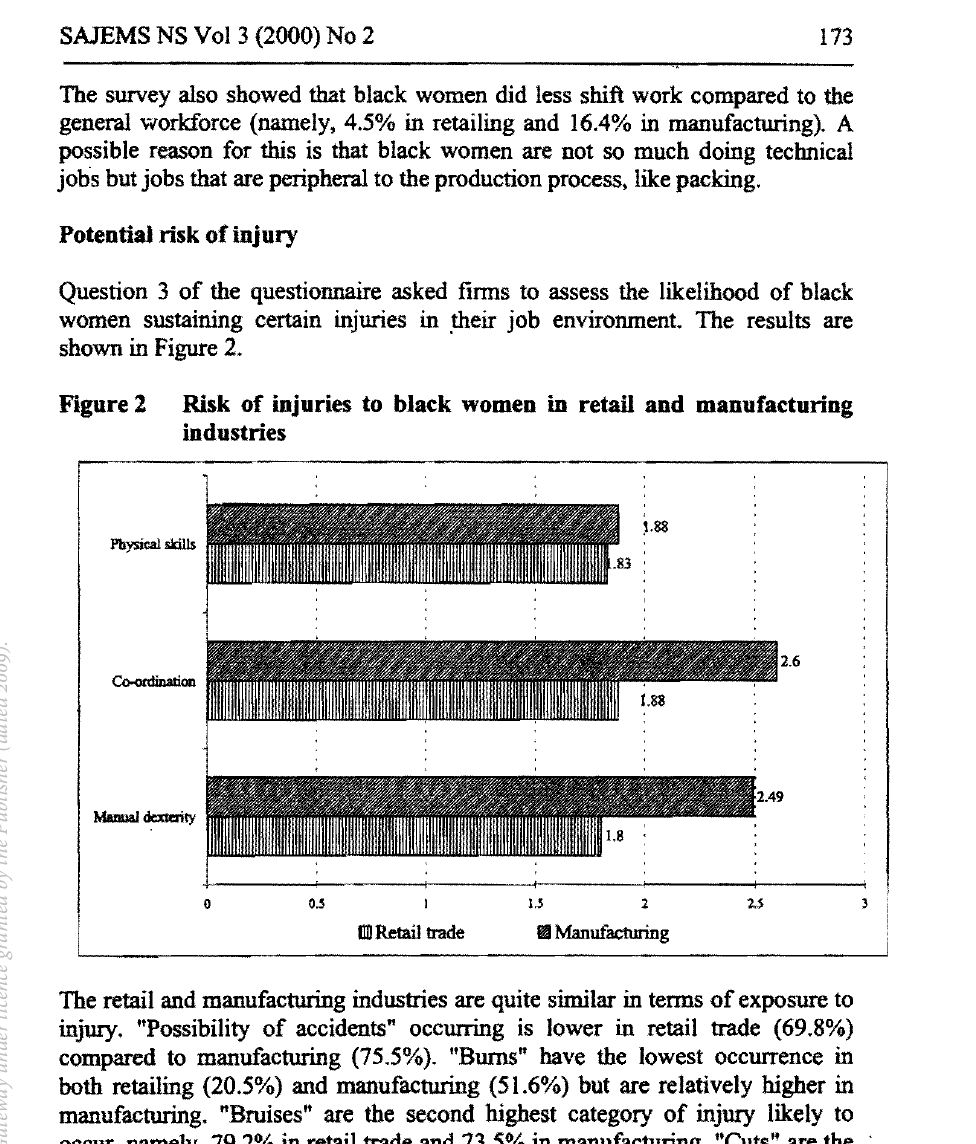
Risk of injuries to black women in retail and